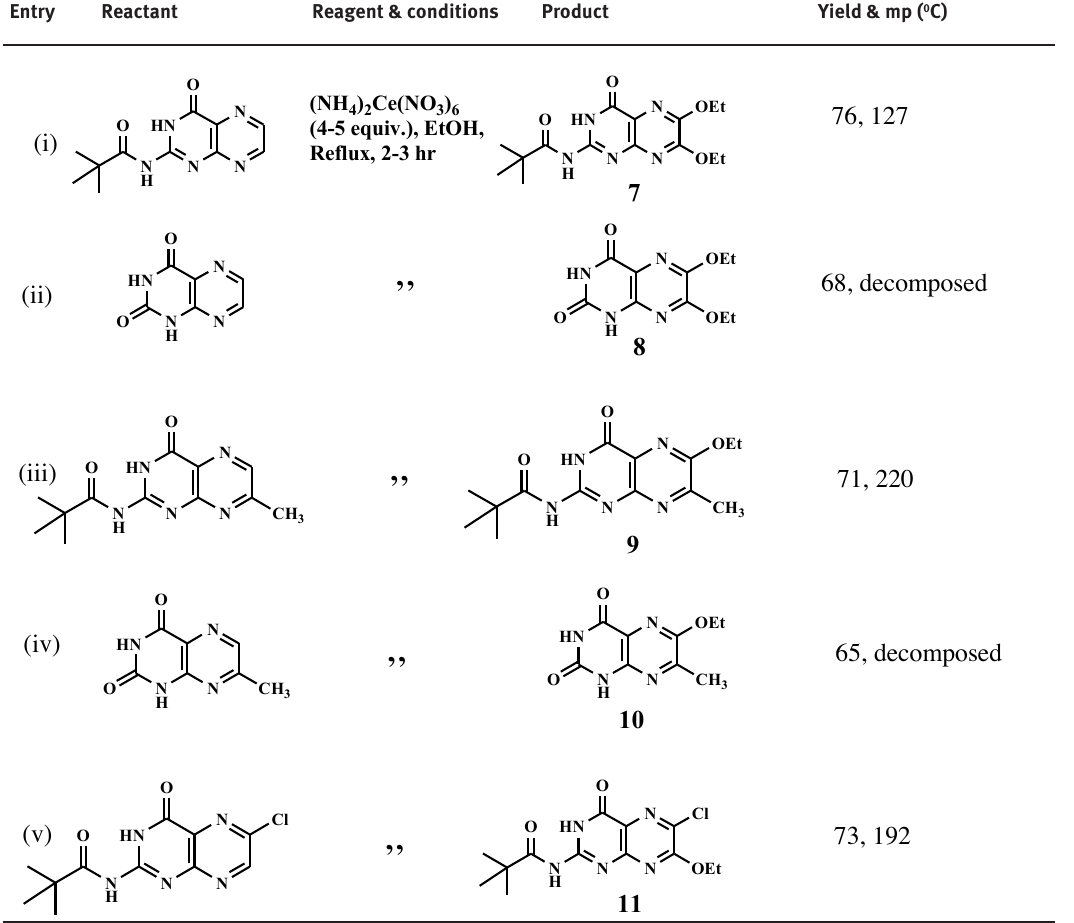
Table 2: Ethoxylation of pterin at 6,7 position using ethanol.